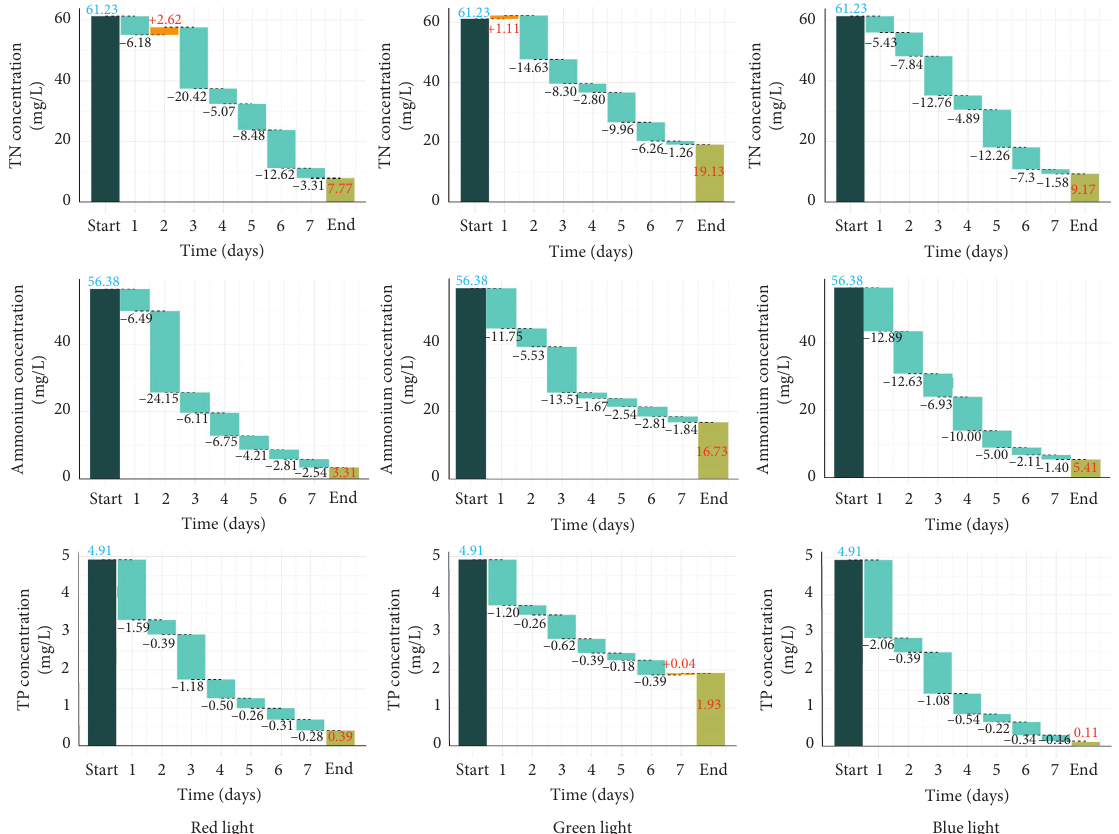
Figure 1: Degradation of campus sewage by Golenkinia SDEC-16 cultured the under red, green, and blue lights. TN represents the total nitrogen concentration; TP represents the total phosphorus